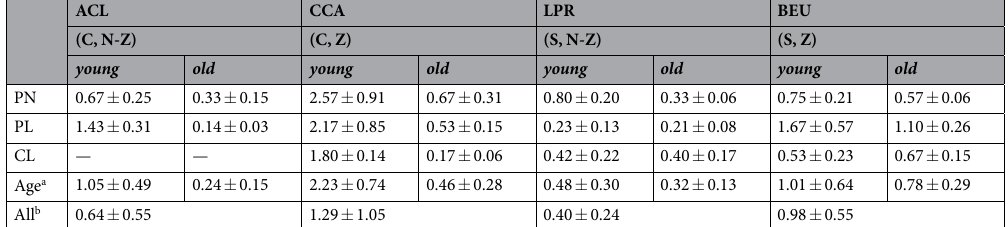
Table 1. Content of fatty acids (wt‰) extracted from A . calycularis (ACL), C . caespitosa (CCA), L . pruvoti (LPR) and B . europaea (BEU) skeletons collected along a latitudinal gradient of temperature in the Tyrrhenian Sea at Pantelleria island (PN), Palinuro (PL) and Calafuria (CL). Three skeletons were analyzed for each species. ACL was not found in CL. C = Colonial, S = solitary, N-Z = Non-zooxanthellate, Z = Zooxanthellate. The standard deviation is reported. a Average FA content in the skeletons from each species grouped in young and old age classes. b Average FA content calculated considering for each species all the data from all the skeletons, independently from the